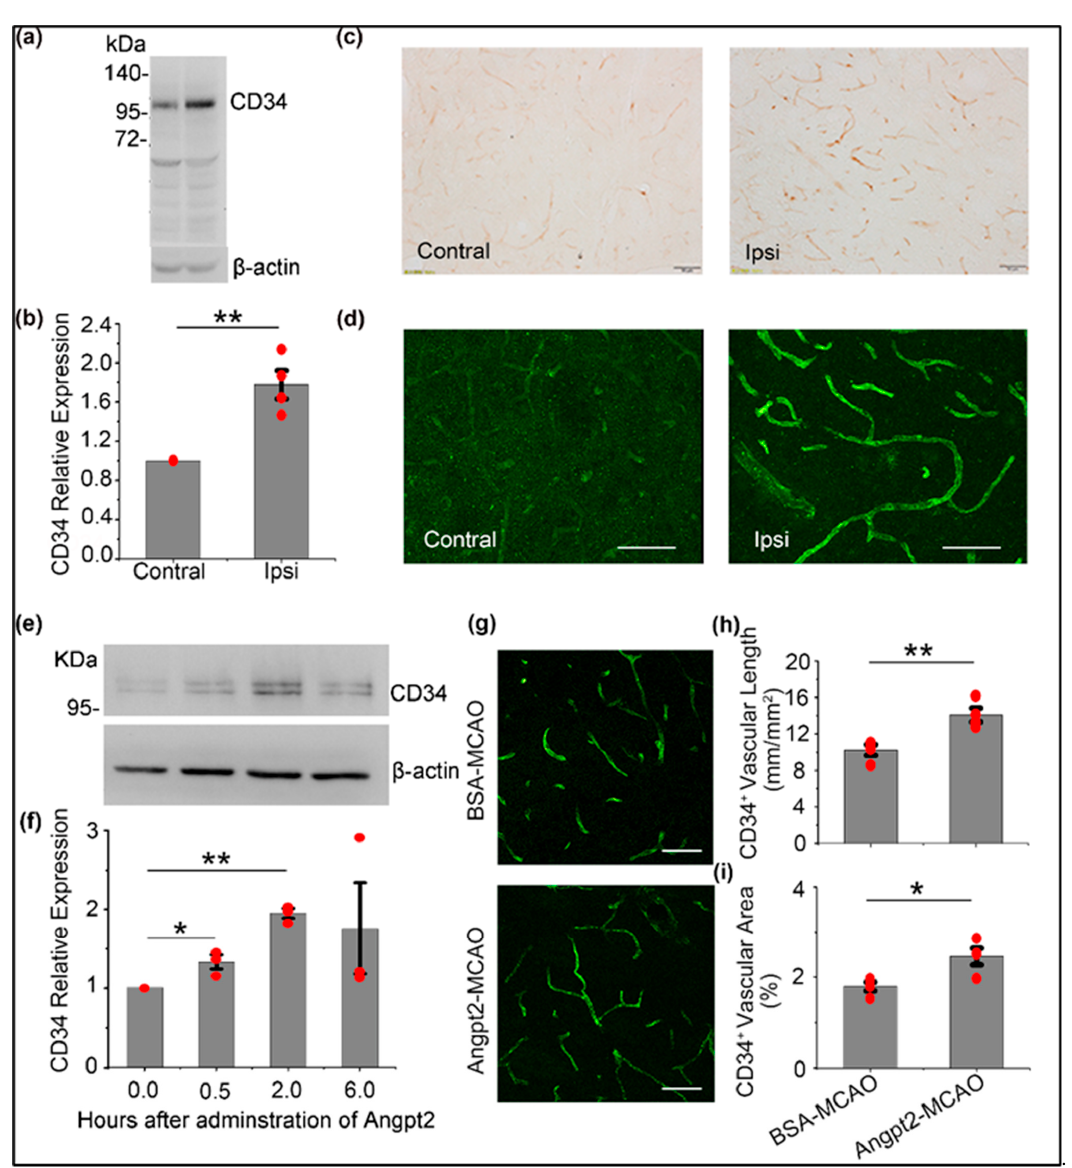
Figure 2. Angpt2 increased CD34 expression in ECs and the CD34 + vascular length and area in mouse brain after ischemic stroke. ( a ) Representative immunoblot with CD34 antibody of contralateral (Contral) and ipsilateral (Ipsi) striatum lysates 3 days after MCAO. ( b ) The bar graph described the relative expression of integrated density of the two bands in ( a ). ( c , d ) Representative images of immunohistochemistry ( c ) and immunofluorescence ( d ) labeling for CD34 in the ipsilateral and contralateral striatum 3 days after MCAO. ( e ) Representative immunoblot with CD34 antibody of cultured ECs at different time points after Angpt2 addition. ( f ) The bar graph described the relative expression of integrated density of the four bands in ( e ). Lines depict SEM ( n = 3). ( g – i ) Angpt2 increased CD34 + vascular length and area after stroke. ( g ) The immunofluorescent image of vessels (green, CD34) in different groups 3 days after injection and operation. The statistics of CD34 + vascular length ( h ) and area ( i ) in different groups 3 days after injection and operation. Scale bars: 50 µ m. Lines depict SEM. ( n = 3 in e and f; n = 4 in other groups; In b, h and i, * p < 0.05, ** p < 0.01 by two-sample t test. In f, * p < 0.05, ** p < 0.01 by one-way AVONA with Tukey’s post hoc